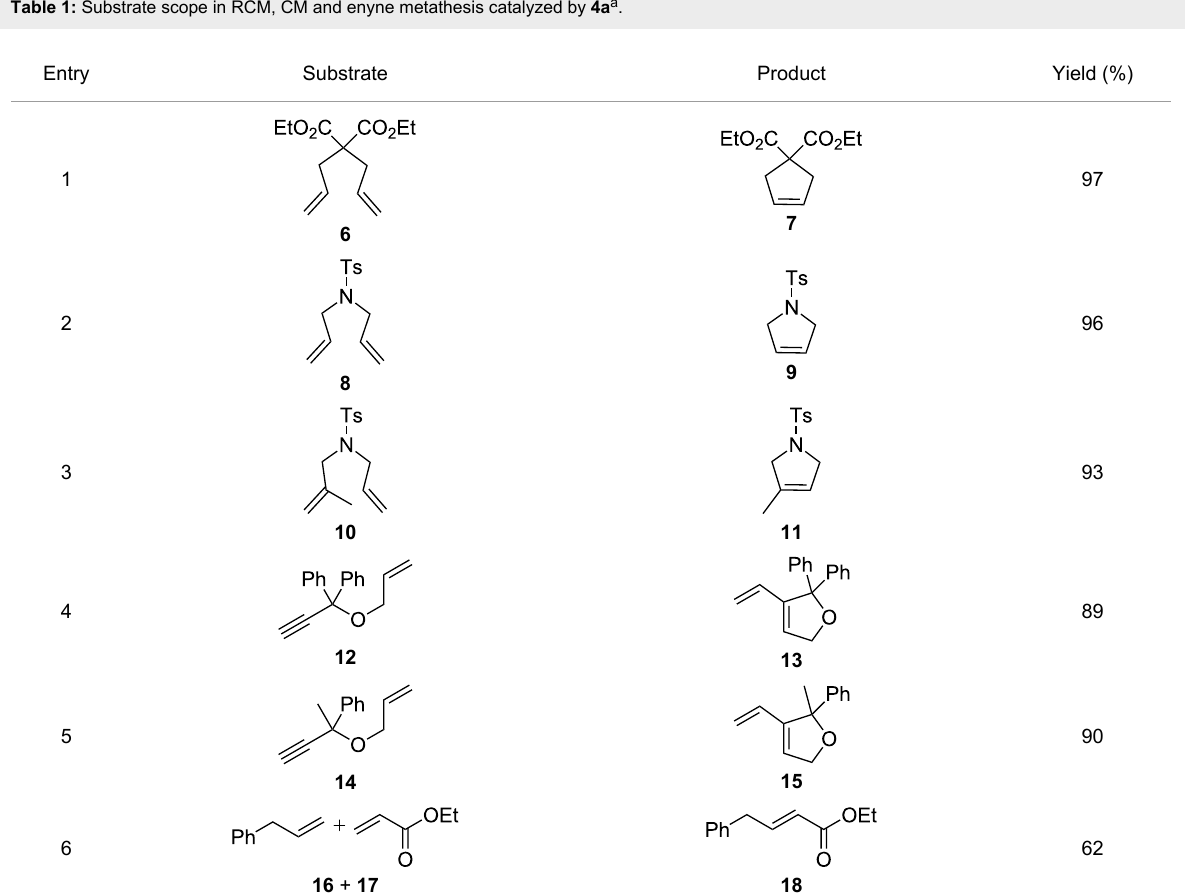
Table 1: Substrate scope in RCM, CM and enyne metathesis catalyzed by 4a a .